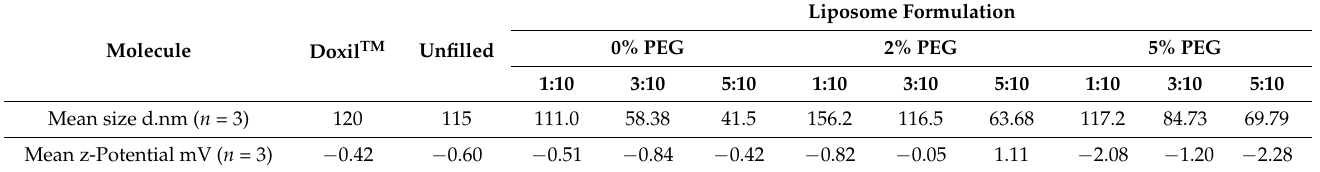
Table 2. Results of DLS analysis of liposomes showing mean size (d.nm) and z-potential (mV).